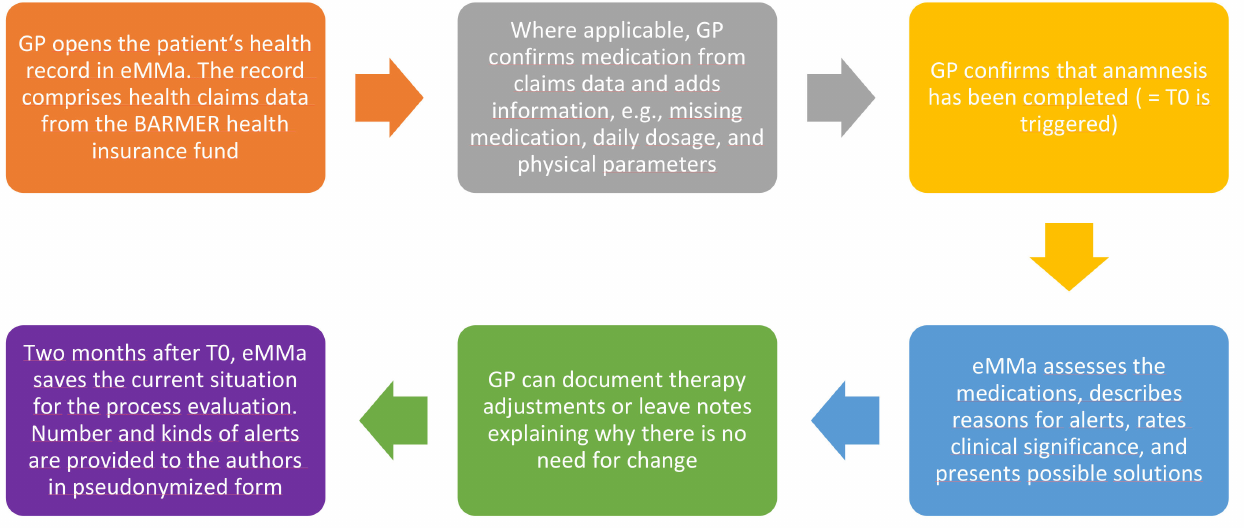
Figure 10. Schematic working process for GPs that use eMMa. The final step (purple field) defines T 1